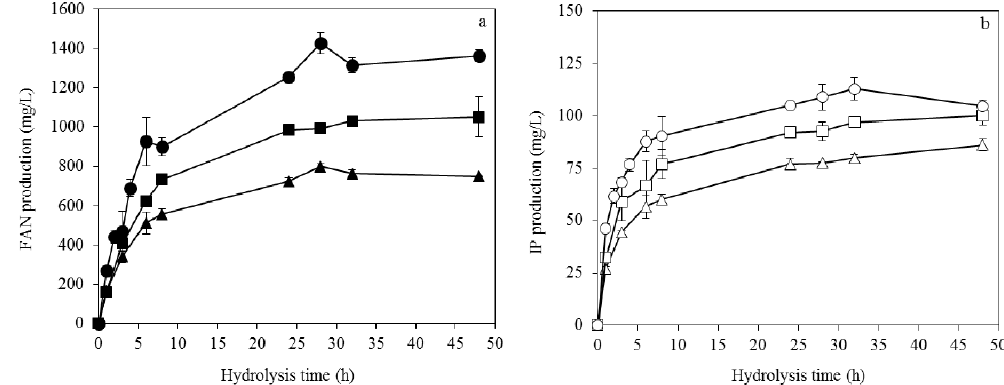
Figure 7. FAN ( a ) and IP ( b ) production during hydrolysis of 45 g/L initial solids (soybean cake and fermented solids from SSF) at 45 °C (circles), 50 °C (squares) and 55 °C (triangles) using initial proteolytic activity of 3.9 U/mL.